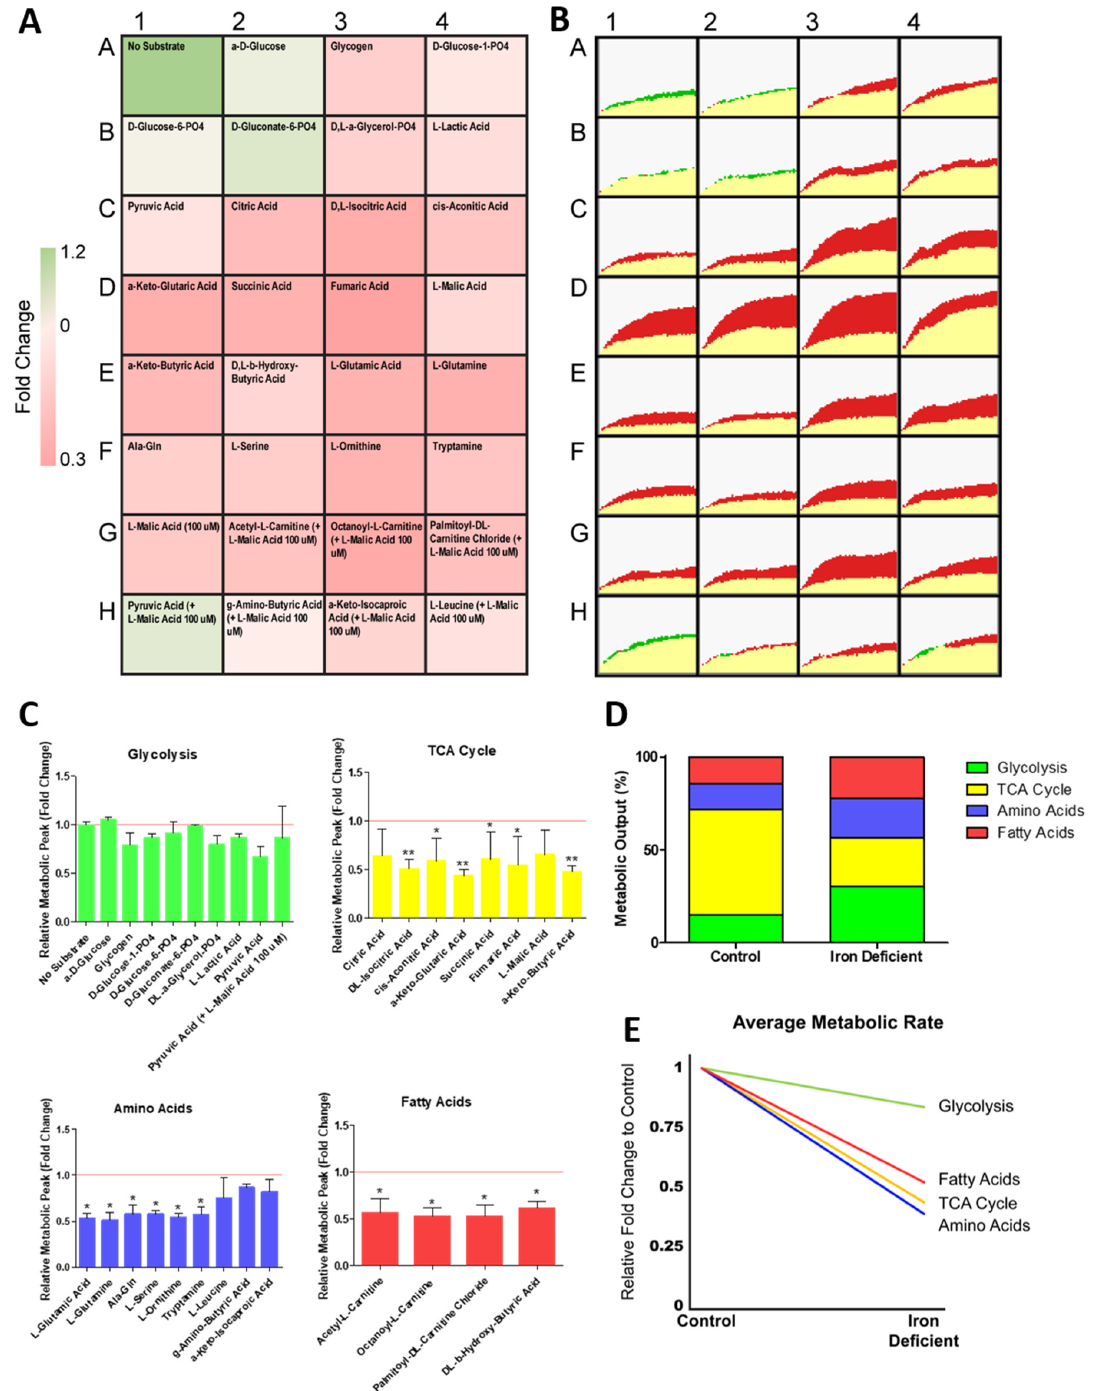
Figure 4. Change in metabolism during hiPSC-CM iron deficiency. In ( A ), relative fold change in the rate of substrate metabolism for iron-deficient hiPSC-CMs normalised to control hiPSC-CMs is shown as a heat map. In ( B ), corresponding representative rate traces are shown for both iron-deficient hiPSC-CMs (shown in yellow/green) and control hiPSC-CMs (shown in yellow/red). ( C ) substrate maximum metabolic capacity for iron-deficient hiPSC-CMs normalised to control hiPSC-CMs. n = 3. In ( D ), the maximum metabolic peak is averaged for each of the glycolysis, TCA cycle, amino acid, and fatty acid substrate groups. In ( E ), the relative fold change in the rate of grouped substrate average is plotted for iron-deficient hiPSC-CMs compared to control. Significance was determined by two-way ANOVA, * p < 0.05, ** p < 0.01.